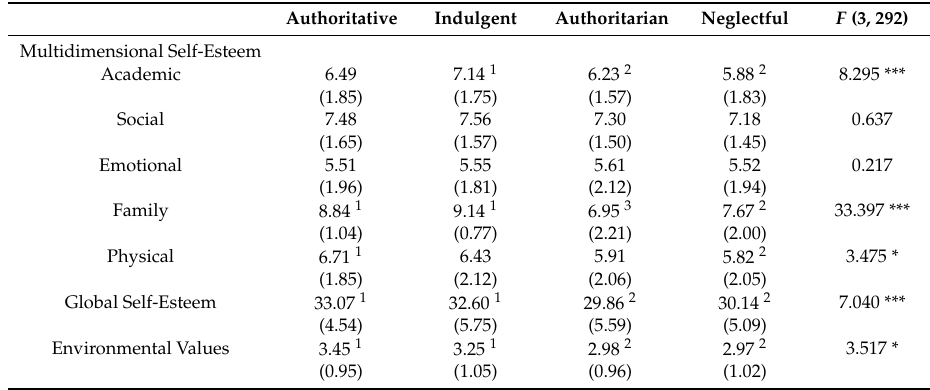
Table 3. Means, standard deviations (in parenthesis), F # values, and Bonferroni test between parenting styles on self-esteem and environmental